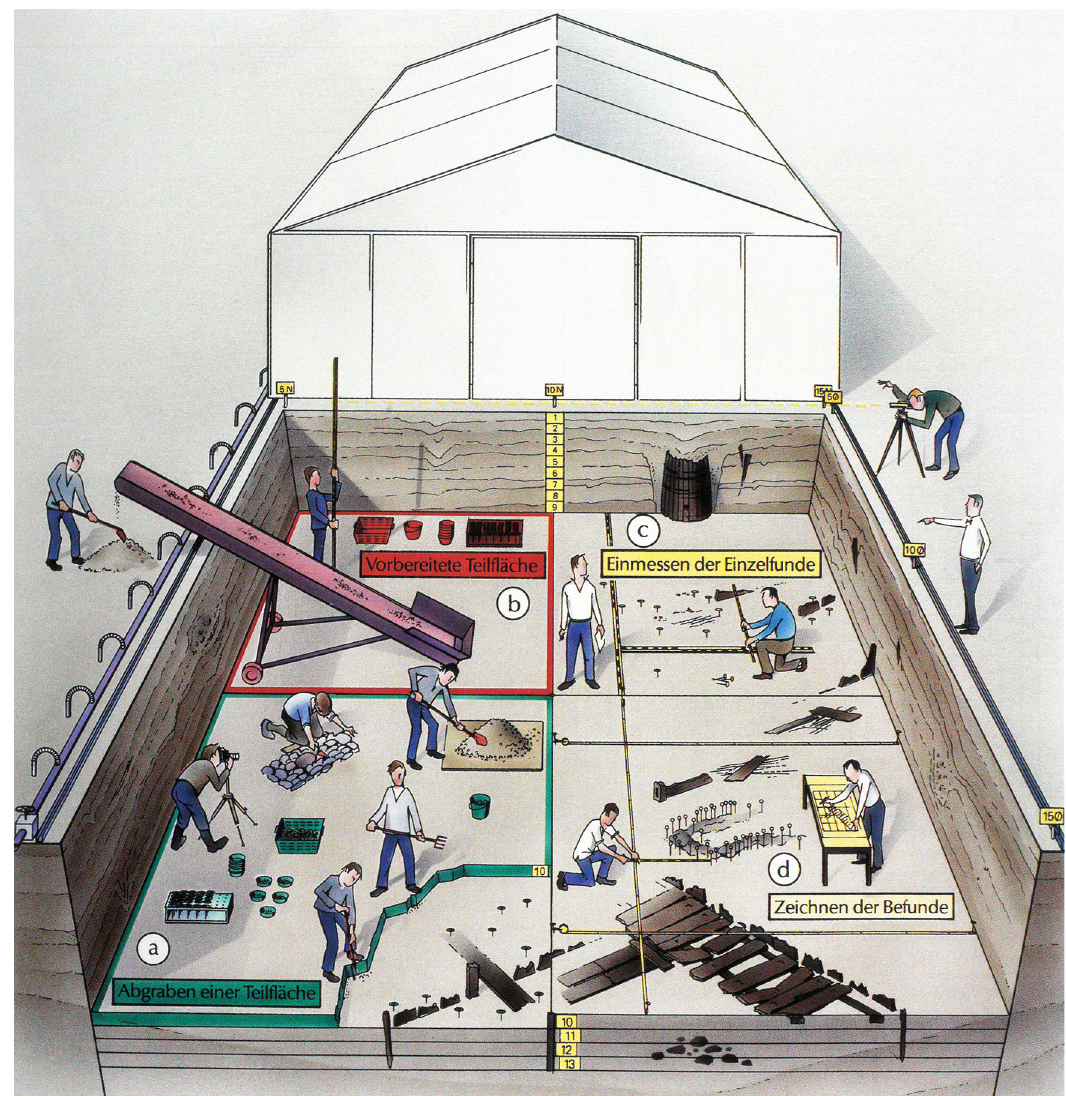
Figure 1: Schema of the fi eldwork work fl ow conducted in Hedeby and Schleswig: ( a ) digging o ff a quadrant, ( b ) prepared quadrant, ( c ) measuring individual fi nds, and ( d ) drawing the features ( after Schietzel, 2014, p. 53 )